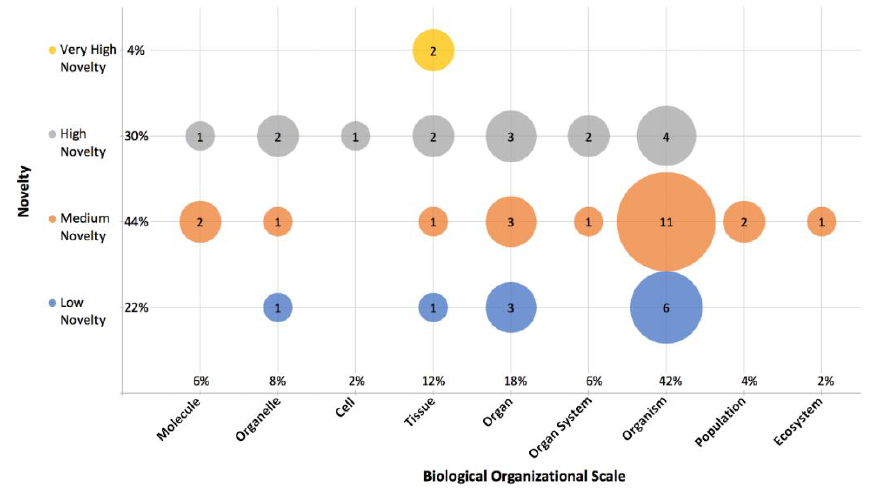
Figure 6. Novelty Distribution of Biomimetic Mechanisms and Processes ( n = 50).